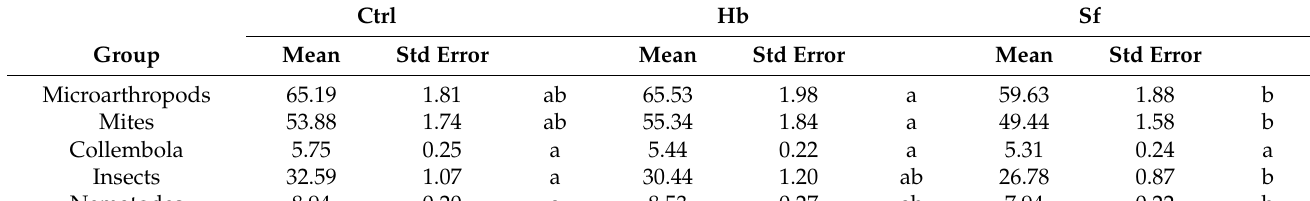
Table 2. Motu richness ( R ) of major taxa in the plots augmented with Heterorhabditis bacteriophora (Hb), Steinernema feltiae (Sf) and the untreated controls (Ctrl). Means in rows with the same letters do not differ ( p < 0.05).